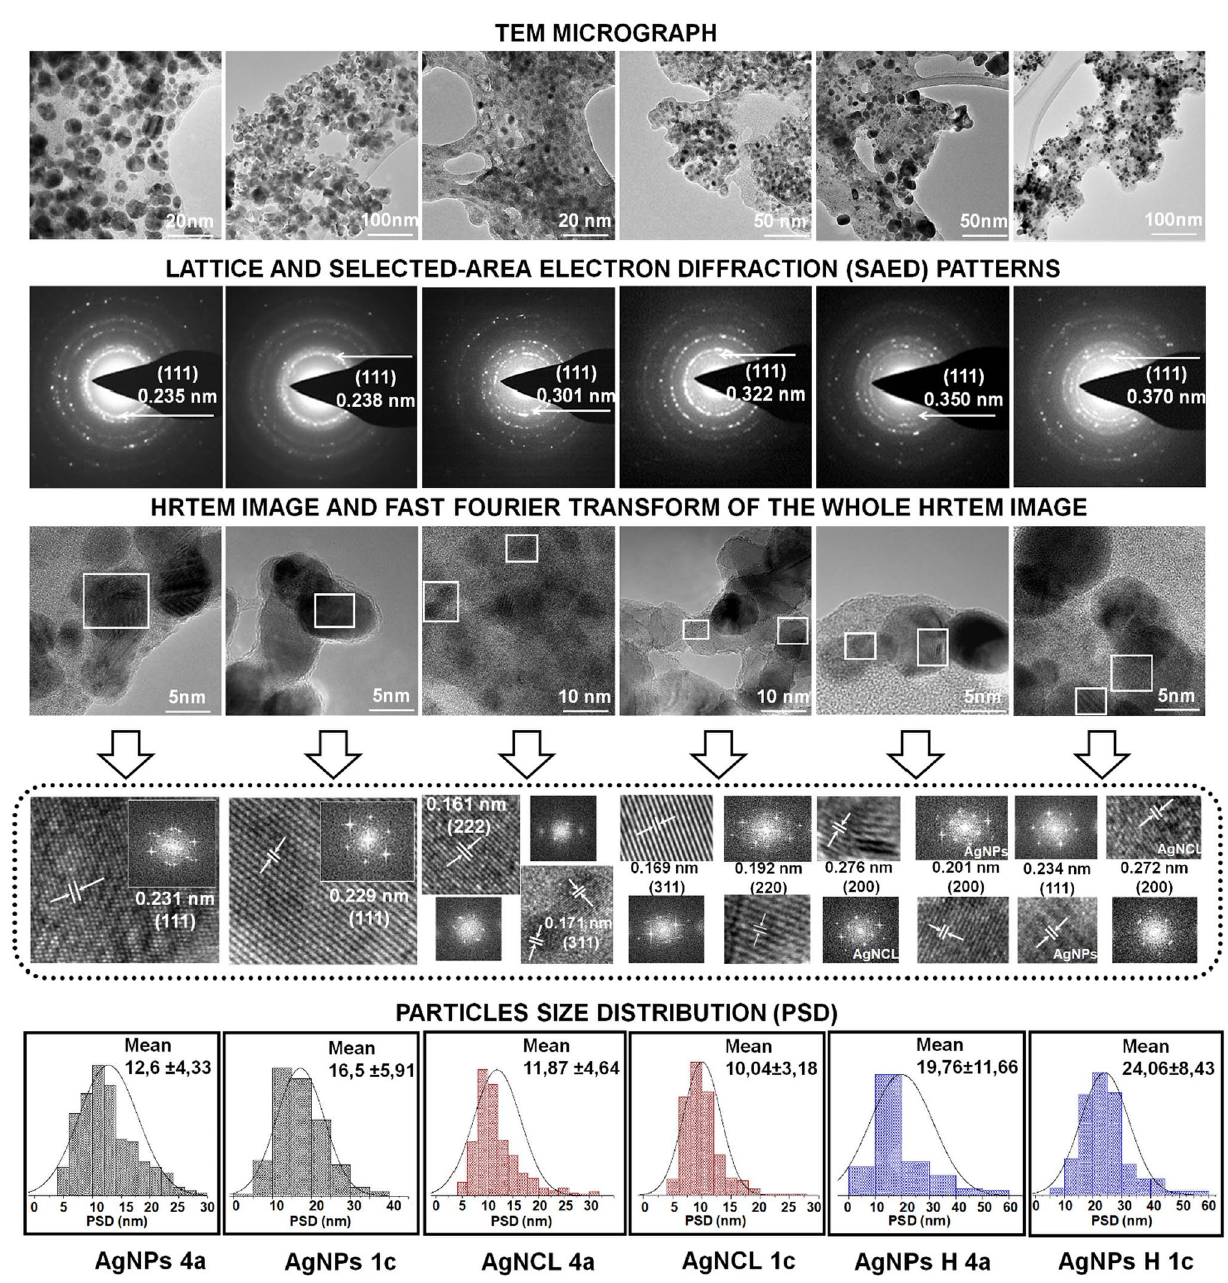
Fig. 4 Illustration of TEM micrograph, lattice and selected-area electron diffraction (SAED) patterns, HRTEM image and Fast Fourier trans- form of the whole HRTEM image showing lattice reflections and particle size distribution of the all synthesized